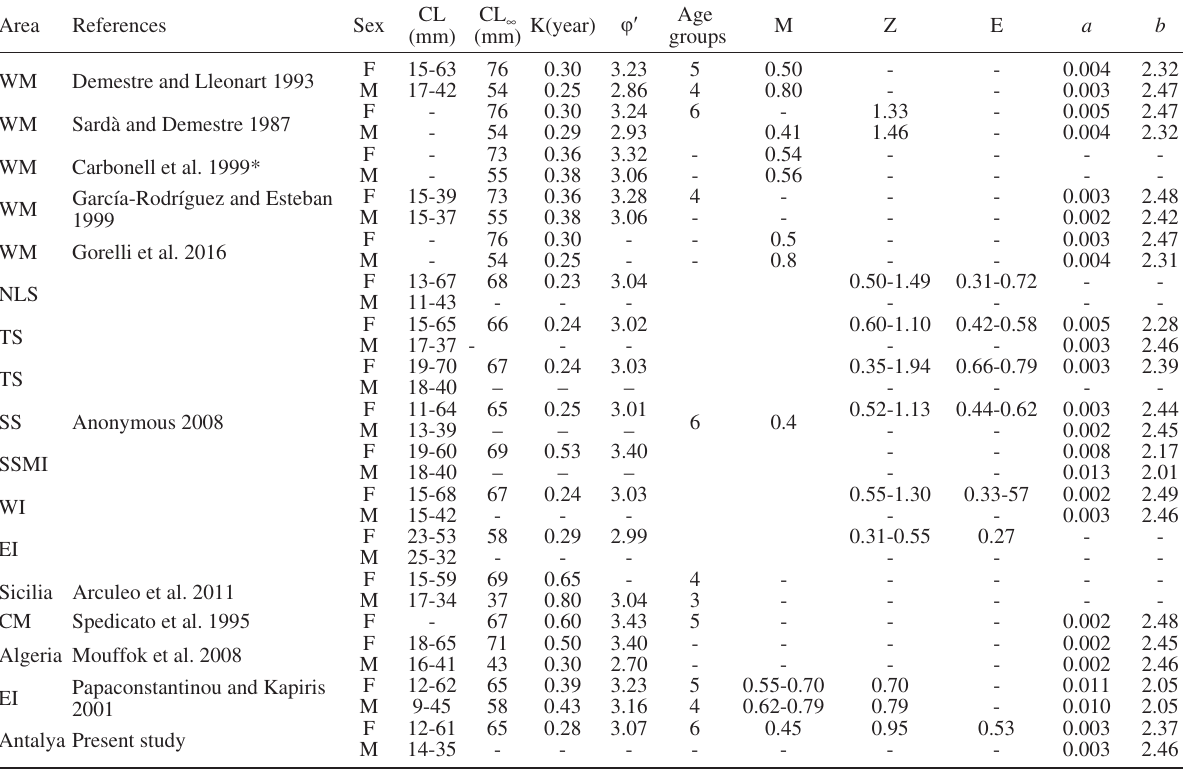
Table 4. – Summary of biological parameters (L , K and t ), identified age groups by sex, mortality and length-weight relationships ( a and b ) 0 ∞ of A. antennatus in various Mediterranean areas. M, natural mortality; Z, total mortality; NLS, Northern Ligurian Sea; TS, Tyrrhenian Sea; SS, Sardinian Sea; SSMI, South Sicily and Maltese Island; WI, Western Ionian; EI, Eastern Ionian; CM, Central Mediterranean; WM, western Mediterranean); *from Papaconstantinou and Kapiris